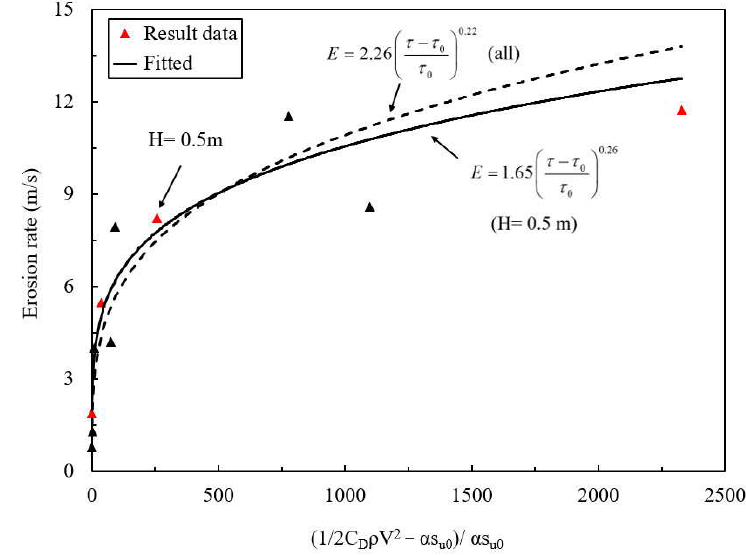
Figure 12. Relationship between the erosion rate and the flow velocity.